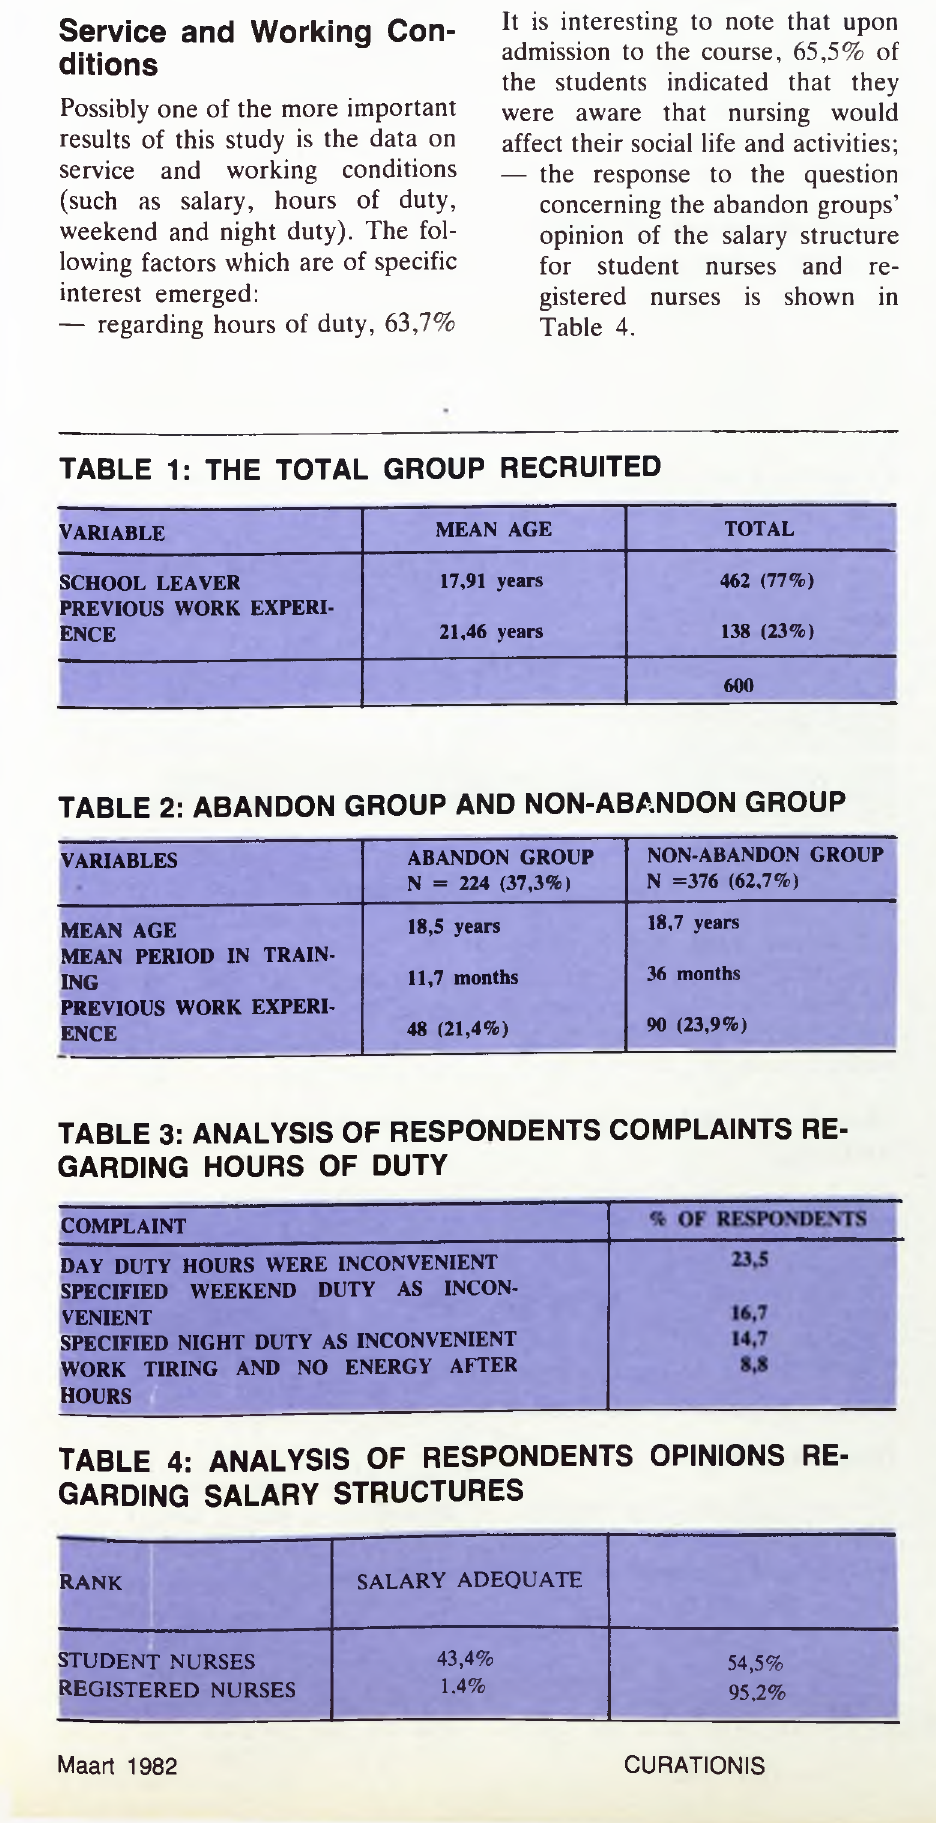
TABLE 4: ANALYSIS OF RESPONDENTS OPINIONS